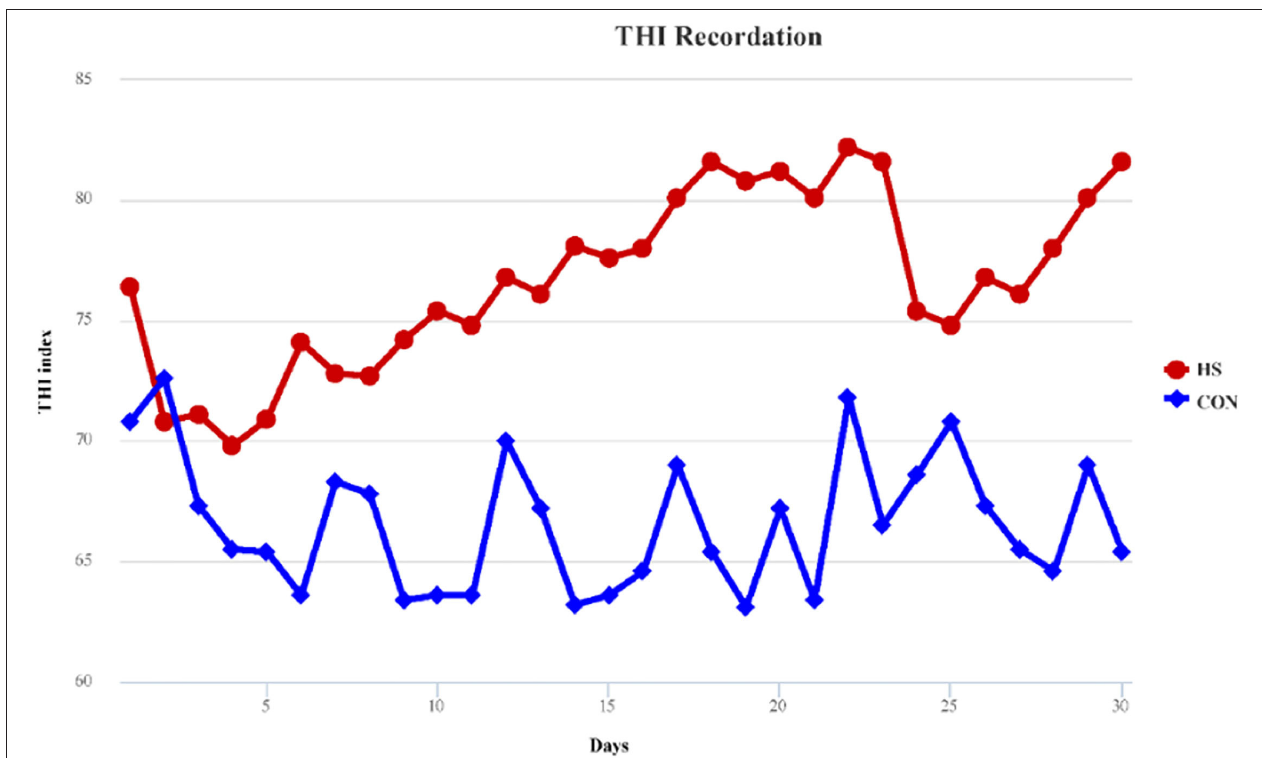
FIGURE 1 | THI record of both heat stress and control treatments. HS, heat stress; CON, control